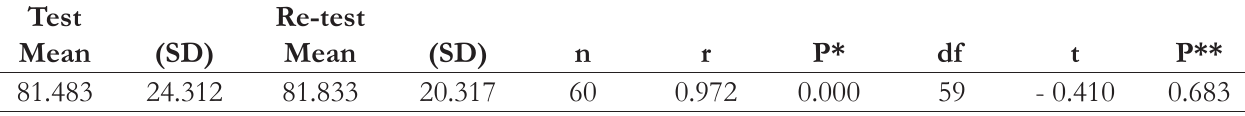
Table 4. Test-retest Reliability between Two Measurements (n = 60) Test Mean